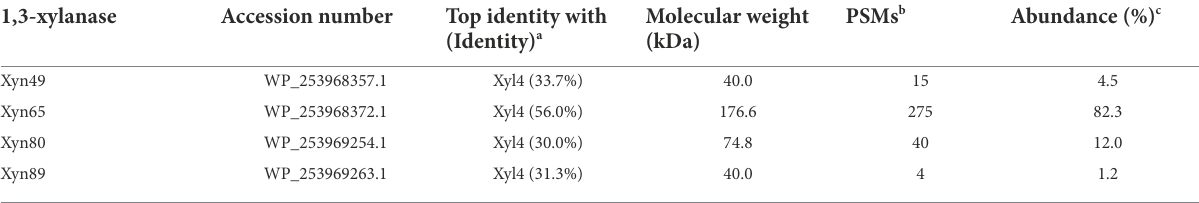
TABLE 2 Information of the extracellular 1,3-xylanases secreted by strain HB14 T identified by secretome analysis. 1,3-xylanase Top identity with (Identity) a